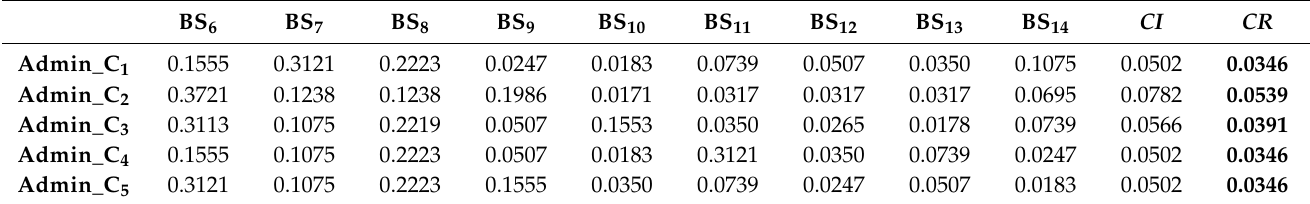
Table A19. The hierarchical single sorting results of Admin _ C i . The CR of each matrix is in bold.